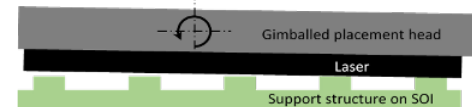
Fig. 3. Rotation alignment through gimbal